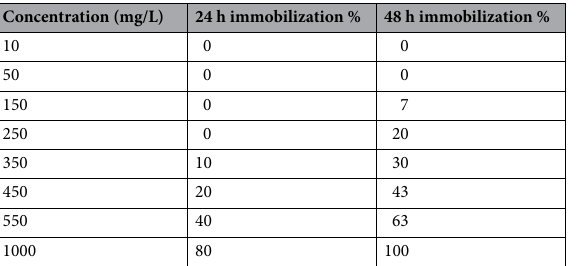
Concentration (mg/L)